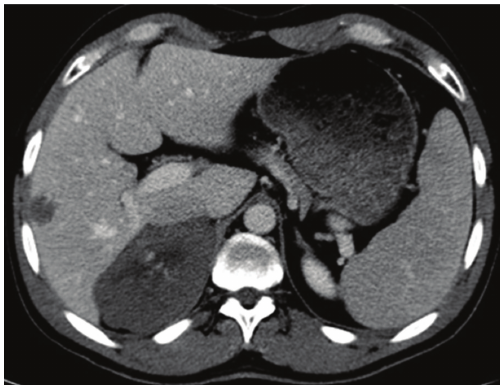
Figure 1: Axial noncontrast CT at the level of adrenal fossa shows a well-capsulated right adrenal solid lesion measured (11 × 6 cm) of relative isodense pattern in comparison to renal parenchyma with central hypodense area; the lesion displays 37HU.